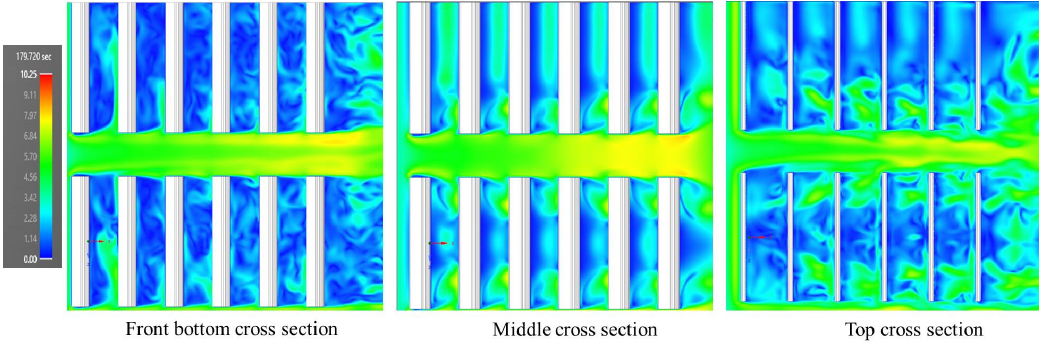
Figure 13. Flow fields of three typical cross sections under different greenhouse arrangement.